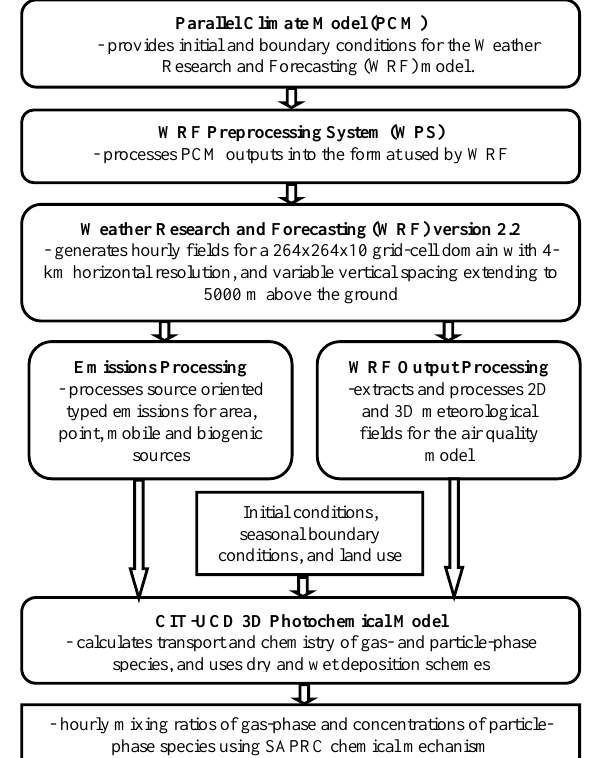
Fig. 1: Flow Chart of the climate downscaling and air quality modeling systems. Fig. 1. Flow Chart of the climate downscaling and air quality modeling